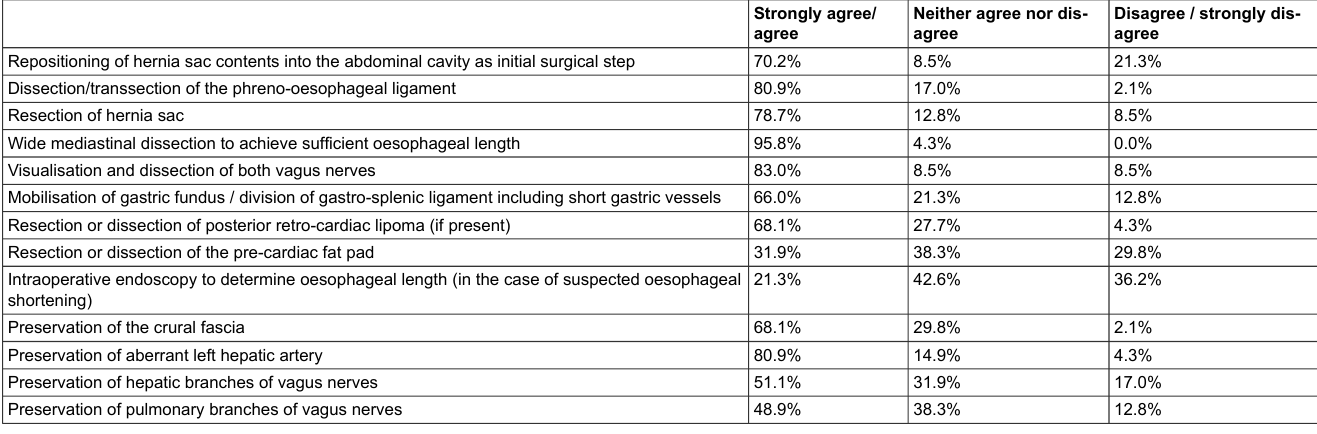
Table 3: Technical details of hiatal